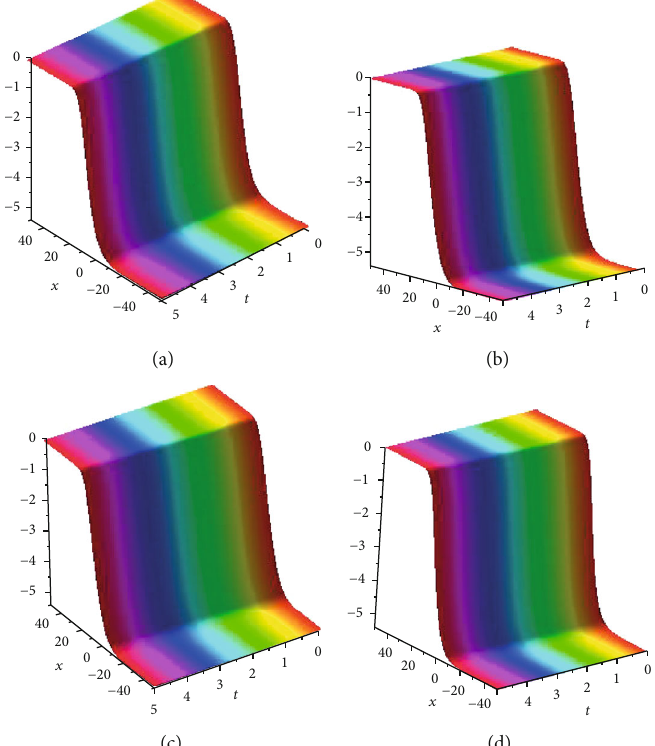
= 1 : 5 , q = 2 , λ = 2 : 2 , M = − 3 , N = 2 , and k = 3 when (a) α = 0 : 25 , (b) α = 0 : 5 , (c) α = 0 : 85 , 2 2